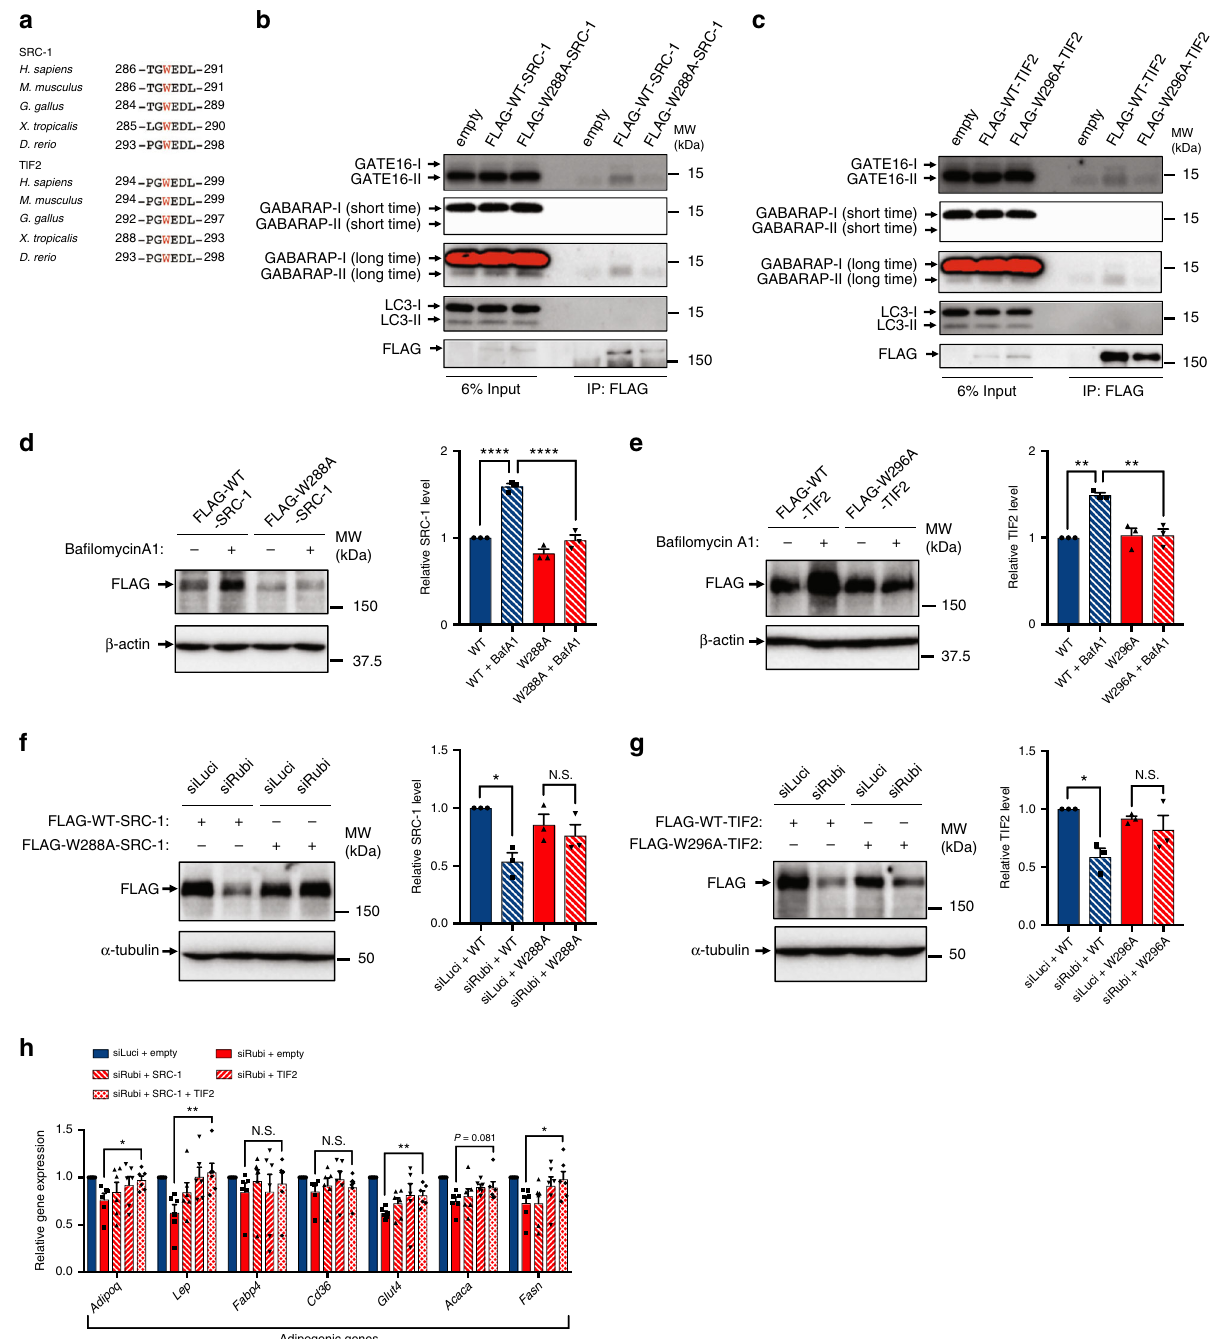
Fig. 7 GABARAP family proteins are co-immunoprecipitated with SRC-1 and TIF2 in an LIR/GIM-dependent manner. a Alignment of LIR/GIM of SRC-1 and TIF2 homologues in various species. b , c Immunoprecipitation assay. HEK293T cells were transfected with the indicated plasmids for 48 h, and then the cells were lysed and immunoprecipitated with anti-FLAG antibody. Precipitates were subjected to immunoblotting with the indicated antibodies. n = 3 independent experiments with similar results. d , e Immunoblotting to detect FLAG in the 3T3-L1 cells overexpressing the indicated plasmids. Twenty-four hours after transfection, the cells were treated with or without 125 nM Baf A1 treatment for 8 h. n = 3 independent experiments. f , g Immunoblotting to detect FLAG in the 3T3-L1 cells. Knockdown was performed for 48 h starting on day 8 following induction of differentiation. The indicated plasmids were transfected for 24 h starting on day 9. Cells were harvested at day 10. n = 3 independent experiments. h Relative mRNA expression of adipogenic genes in 3T3-L1 cells. Knockdown was performed for 48 h starting on day 8 following induction of differentiation. FLAG-W288A-SRC-1 and/or FLAG-W296A TIF2 plasmids were transfected for 24 h starting on day 9. FLAG-only plasmid was used as empty vector. Cells were harvested at day 10. n = 6 independent experiments. Quanti fi cation data are shown in the graphs at the right of each blot. Error bars indicate means ± SEM. Data were analysed by two-tailed Student ’ s t test ( h ), one-way ANOVA followed by Tukey ’ s test ( d – g ). P value from left to right: <0.0001, <0.0001 ( d ), 0.0013, 0.0019 ( e ), 0.0106, 0.8148 ( f ), 0.0170, 0.7972 ( g ), 0.0268, 0.0082, 0.5758, 0.6119, 0.0040, 0.0810, 0.0462 ( h ). * P < 0.05; ** P < 0.01; *** P < 0.001. N.S. not signi fi